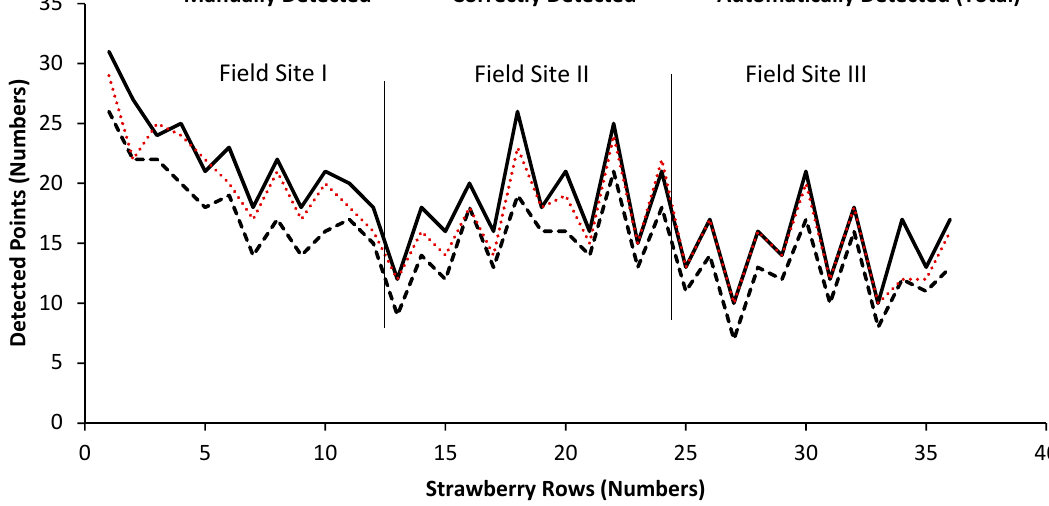
Figure 12. Strawberry powdery mildew disease detection comparison row by row between manually and automatically detected points.